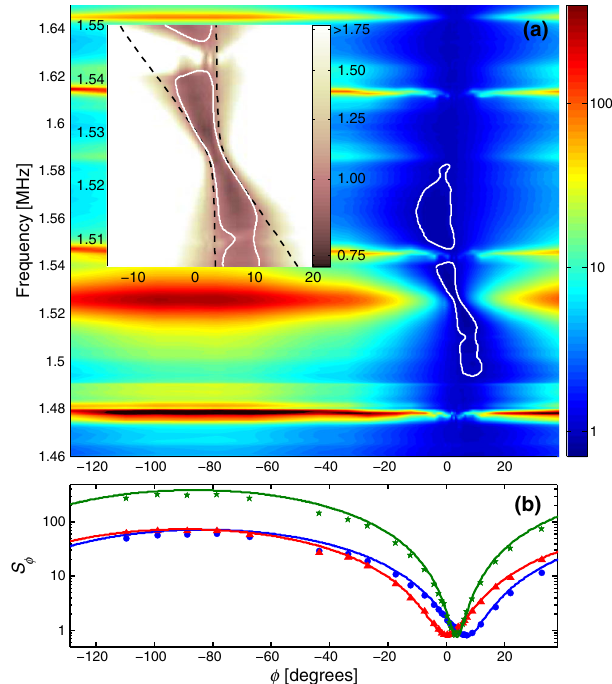
FIG. 3. Optical quadrature spectrum. (a) Color map of S white contour is at the shot-noise level, and the region inside this contour is squeezed. Several additional noise peaks are evident at frequencies away from the mechanical resonance, due to motion of thermally occupied modes of the support structure. The inset shows the squeezed region in more detail and also includes a theoretical prediction (dashed black curves) of the expected shot- noise contour. The experimental parameters are the same as in Fig. 2, except (cid:1) = 2 (cid:4) ¼ (cid:4) 42 kHz . (b) Cuts through quadrature phase at three different frequencies 1.517 MHz (blue circles), 1.526 MHz (green stars), and 1.535 MHz (red triangles), aver- aged over a 1-kHz bandwidth, and corresponding to zero-free- parameter theoretical models (colored solid